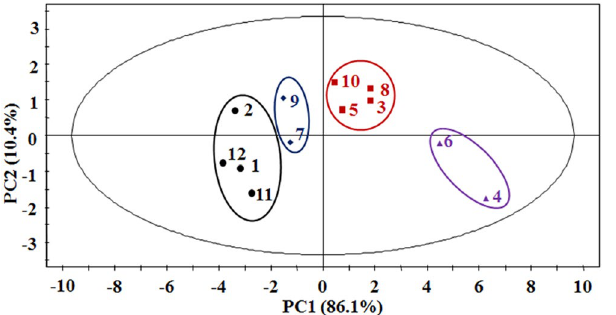
Figure 2. Classifications of food taking patterns for 12 beagles depending on the PCA method. For the score plot, PC1 explained variability X 86.1%, PC2 explained variability X 10.4%.